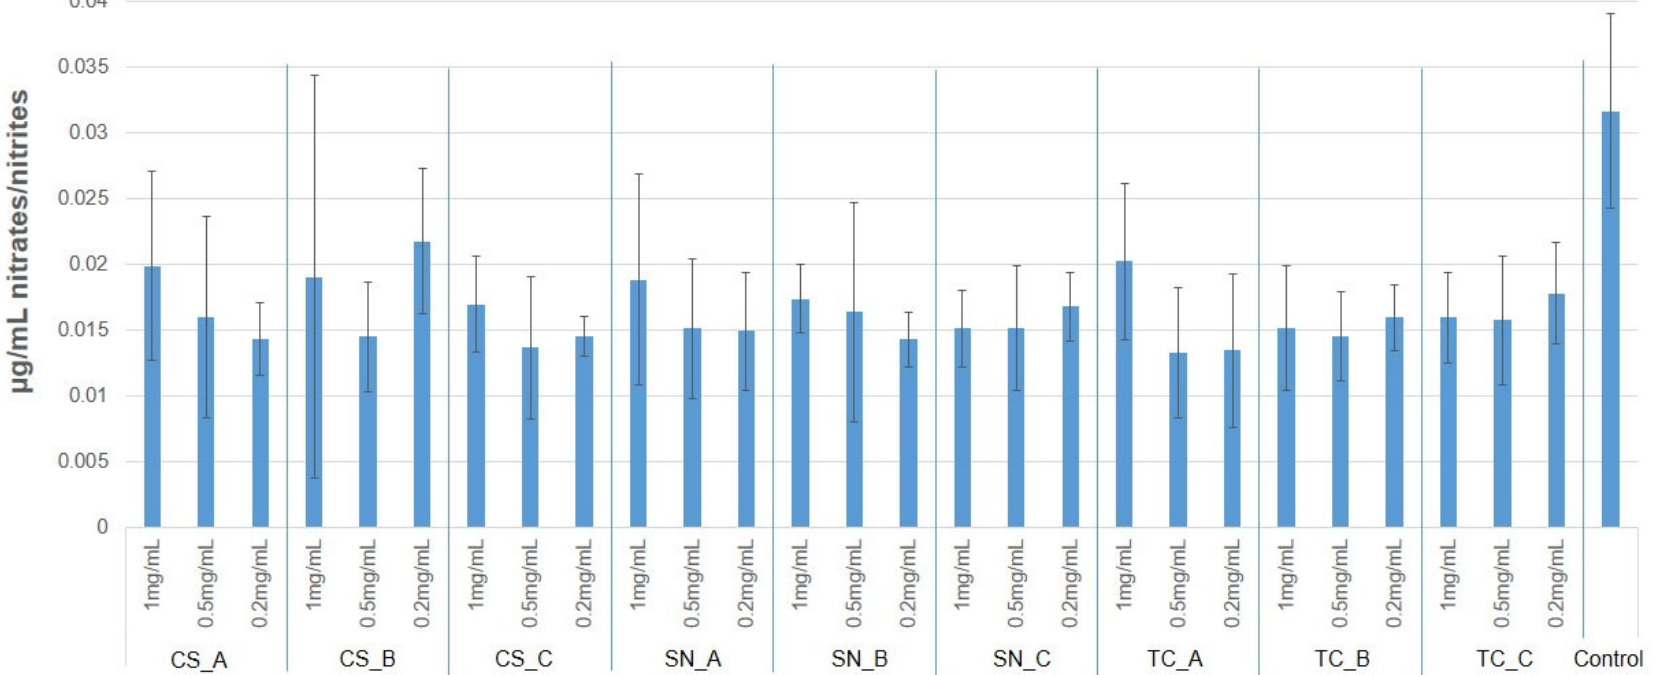
Figure 10. NO production of human BJ cells, after treatment with nonexposed/exposed to acidic artificial saliva of CAD/CAM restorative materials powders, at three tested concentrations (1 mg/mL; 0.5 mg/mL, and 0.2 mg/mL).